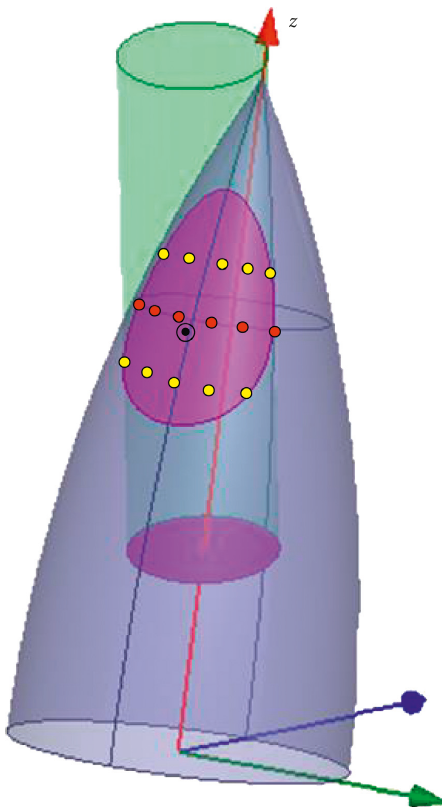
Figure 3: 3D case of antenna-radome system.